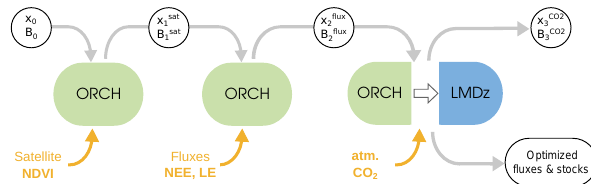
Figure 2. Illustration of the stepwise data assimilation ap- proach used for the assimilation of multiple data streams in the ORCHIDEE-CCDAS. The list of parameters for each step is sum- marized in Table